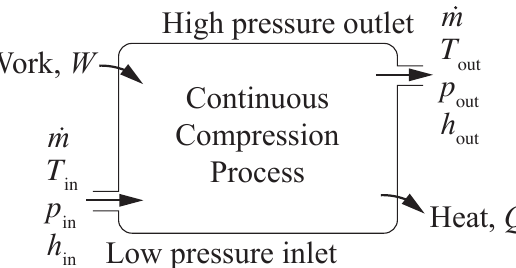
Figure 2. Hydrogen flowing through a compressor, exiting at increased pressure due to work added and heat